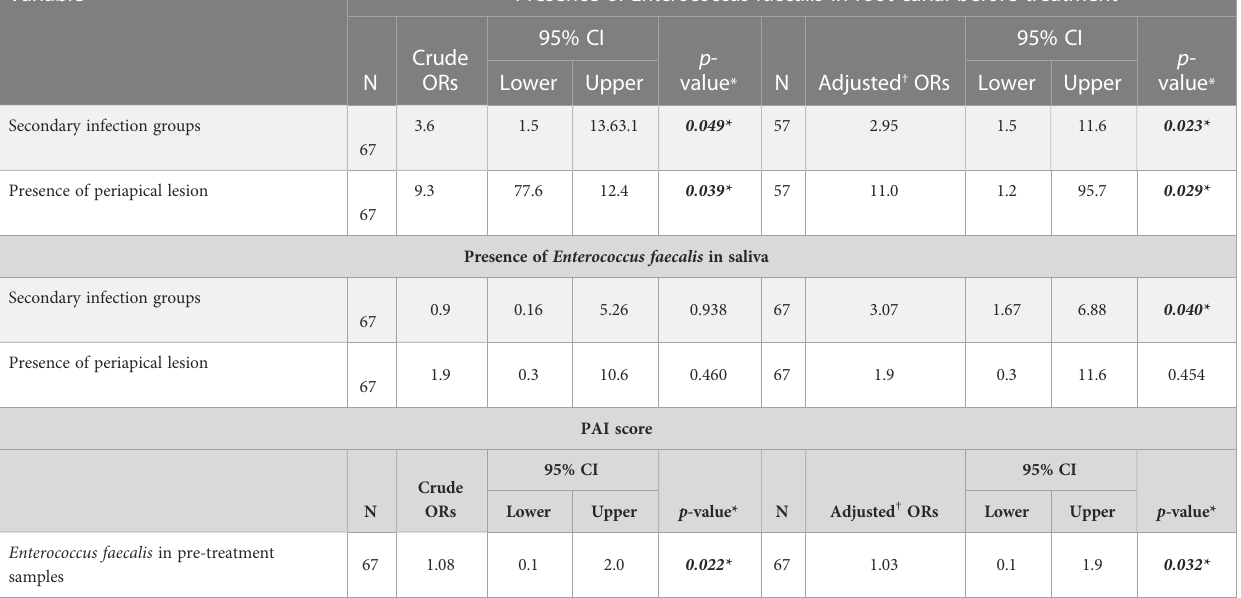
TABLE 3 Linear/logistic regression analyses for the association between E.faecalis in the root canal/saliva and PAI score with clinical variables, respectively. Variable